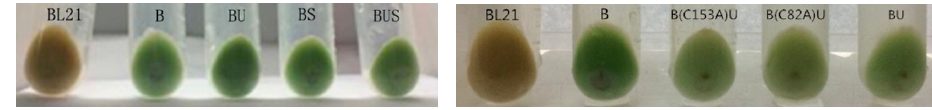
Figure 2. Color of cell pellets of transformed E. coli strains.